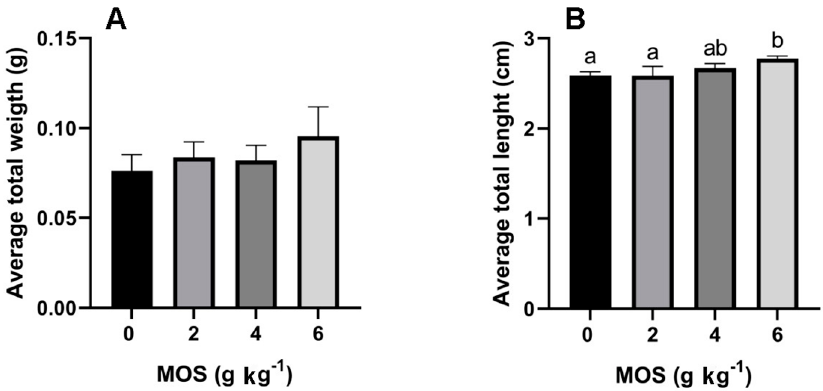
Figure 1. Effect of mannan-oligosaccharides on ( A ) average total weight and ( B ) average total length of A . tropicus larvae. Letters above bars indicate differences between groups ( p > 0.05).